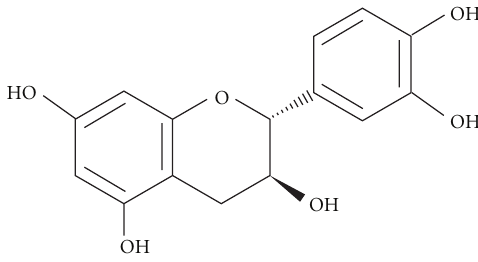
Figure 3: Structural formula of catechin with six-membered ring and hydrophilic group.